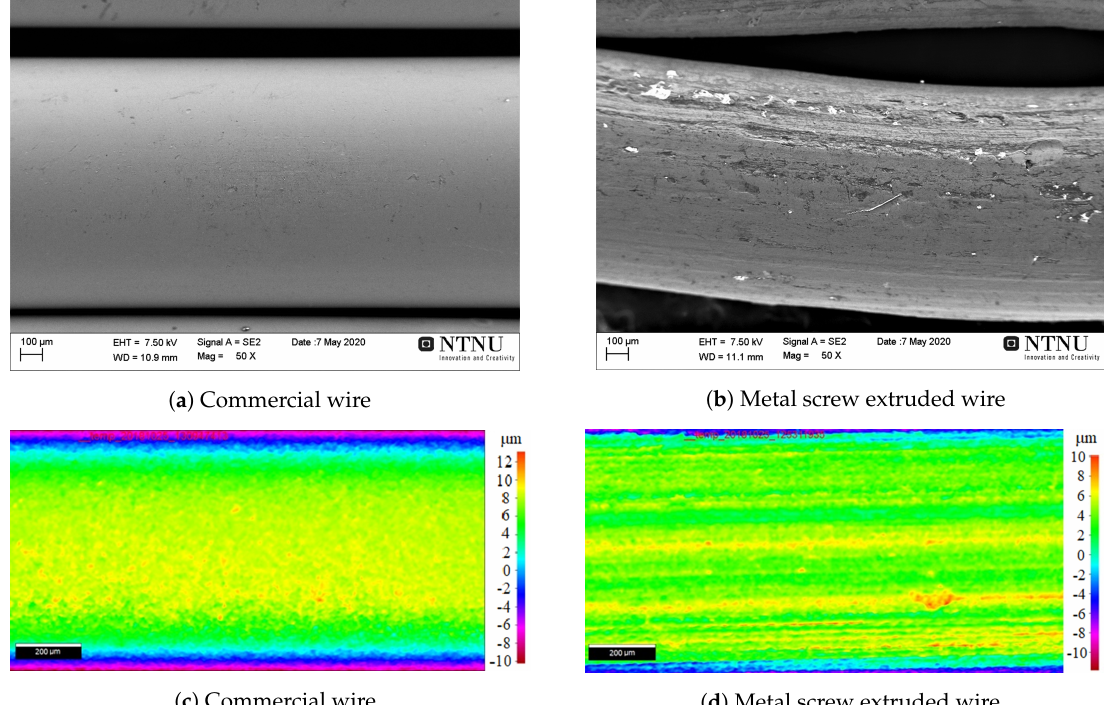
Figure 9. Surface quality of commercial AA4043 wire and metal screw extruded AA4043-TiC wire by SEM ( a , b ) and profilometer measurements ( c , d ). The commercial AA4043 material exhibited excellent surface quality due to surface shaving, whereas the metal screw extruded counterpart possessed a rough outer